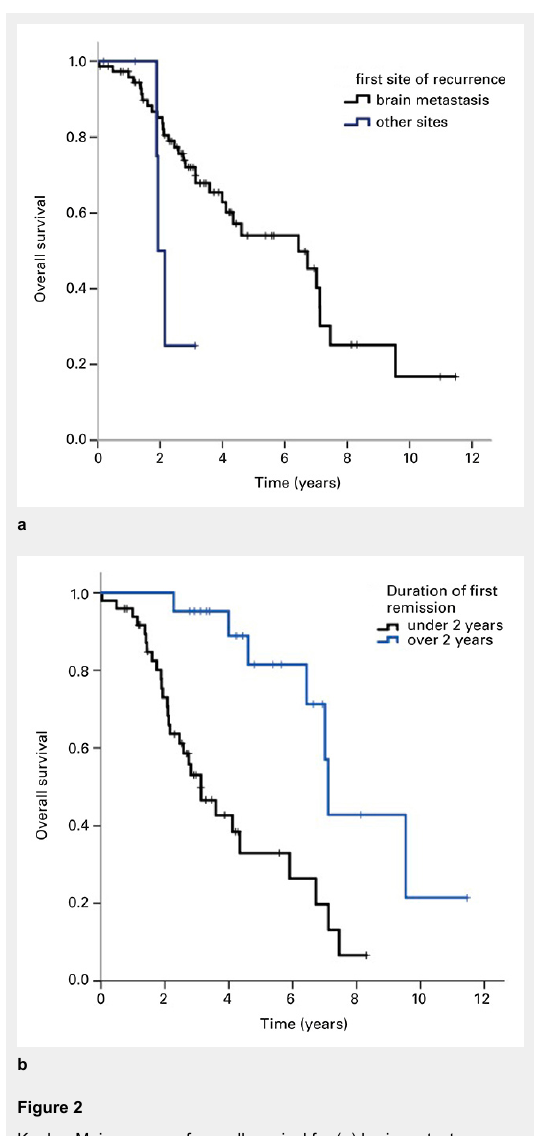
Kaplan-Meier curves of overall survival for ( a ) brain metastases as first site of recurrence vs other sites, p = 0.043 and ( b ) duration of first remission <2 years vs ≥2 years, p